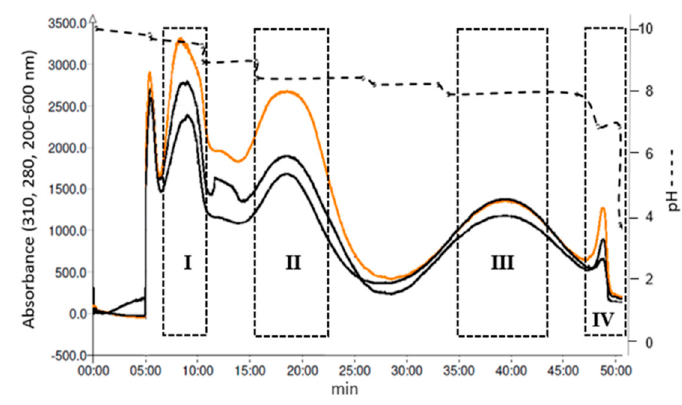
Figure 2. Illustrative pH-zone-refinement Centrifugal Chromatography separation of main alkaloids from Rhodolirium speciosum . Conditions: stationary phase, the upper phase of MtBE / ACN / W (4:1:5, v / v / v ); detection, 280 nm (orange line); flow-rate, 12 mL / min; revolution speed, 1800 rpm, 6 mM formic acid in lower stationary phase and 15 mM TEA in upper phase, sample loading 556.2 mg. Retention of stationary phase was 76%.